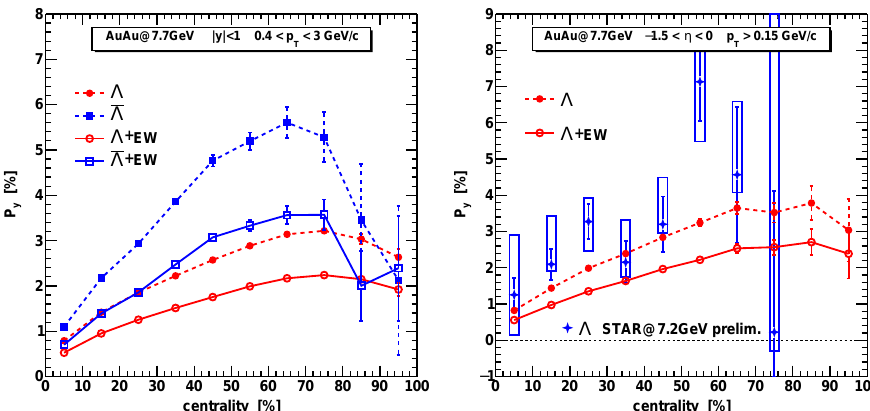
Figure 6. Global polarization of Λ and ¯ Λ depending on the collision centrality in Au+Au col- √ s NN = 7.7GeV is shown for the mid-rapidity | y | < 1 and transverse momentum lisions at 0.4 < p T < 3GeV/ c regions on the left panel and for the pseudo-rapidity range − 1.5 < η < 0 and p T > 0.15GeV/ c on the right panel. Star symbols on the right panel show the results of the STAR collaboration [46] for the same p T and rapidity ranges but energies